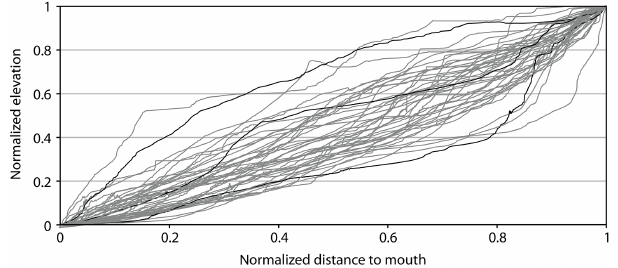
Figure 5. Longitudinal river profiles with normalized distance and elevation.